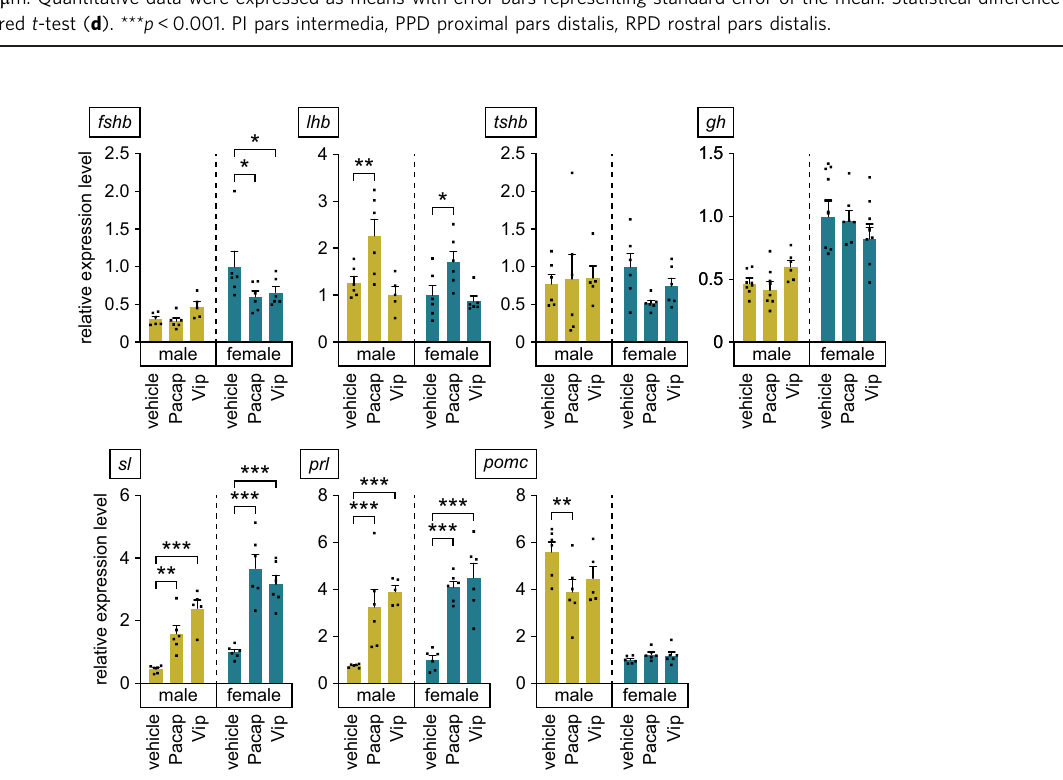
Fig. 8 Pacap and Vip have pleiotropic effects on the expression of anterior pituitary hormones. The effects of Pacap and Vip on gene expression levels of follicle-stimulating hormone β subunit ( fshb ), luteinizing hormone β subunit ( lhb ), thyroid-stimulating hormone β subunit ( tshb ), growth hormone ( gh ), somatolactin ( sl ), prolactin ( prl ), and pro-opiomelanocortin ( pomc ) were investigated by using male and female pituitaries cultured ex vivo ( n = 6 per group, except male pituitary supplemented with Vip, where n = 5). Data were expressed as means with error bars representing standard error of the mean. Statistical differences were assessed by Dunnett ’ s post-hoc test. * p < 0.05; ** p < 0.01; *** p < effect of treatment, p = 0.1252; interaction between sex and < 0.0001 for Pacap in females and Vip in both sexes; main effect treatment, p = 0.0557) (Fig. 8). Expression of the luteinizing of sex, p < 0.0001; main effect of treatment, p < 0.0001; interaction hormone (Lh) β subunit ( lhb ) gene in both male and female between sex and treatment, p = 0.0108. prl : p = 0.0005 for Pacap pituitaries was increased by Pacap supplementation ( p = 0.0045 in males and < 0.0001 for Pacap in females and Vip in both sexes; and 0.0452, respectively), whereas Vip had no signi fi cant effect main effect of sex, p = 0.1199; main effect of treatment, p < (main effect of sex, p = 0.0743; main effect of treatment, p < 0.0001; interaction between sex and treatment, p = 0.7814) 0.0001; interaction between sex and treatment, p = 0.6211) (Fig. 8). The expression of pomc in male pituitaries was reduced (Fig. 8). Pacap and Vip had no signi fi cant effects on expression of by Pacap supplementation ( p = 0.0025), whereas Vip had no the thyroid-stimulating hormone β subunit ( tshb ) or growth signi fi cant effect ( p = 0.0617). In contrast, neither Pacap nor Vip hormone ( gh ) gene in either sex ( tshb : main effect of sex, p = had no signi fi cant effects on pomc expression in female pituitaries 0.6452; main effect of treatment, p = 0.5120; interaction between (main effect of sex, p < 0.0001; main effect of treatment, p = sex and treatment, p = 0.3104. gh : main effect of sex, p < 0.0001; 0.1068; interaction between sex and treatment, p = 0.0239) main effect of treatment, p = 0.8933; interaction between sex and (Fig. 8). treatment, p = 0.1613) (Fig. 8). The levels of sl and prl expression In summary, both Pacap and Vip have sex-independent were substantially increased by both Pacap and Vip supple- mentation in both sexes ( sl : p = 0.0079 for Pacap in males and